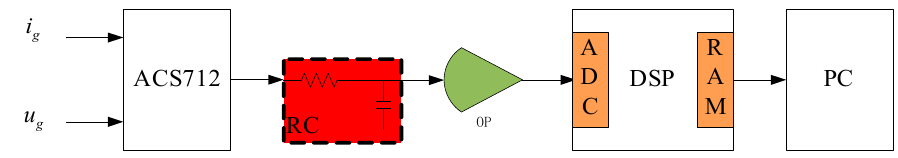
Figure 13. Grid input voltage and current sample circuits. Table 1. Drive and system parameters.